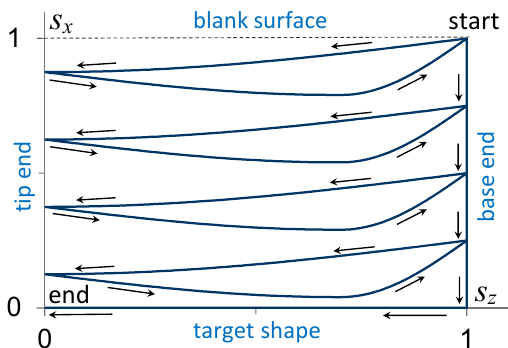
Figure 4. Example of normalized tool paths. The roller starts from the blank surface of the base end and proceeds to the tip end increasing the radial feed. Then, the roller returns to the base end and the radial feed is increased. This is repeated until s x = 0 and the roller moves along the target shape to the tip end.